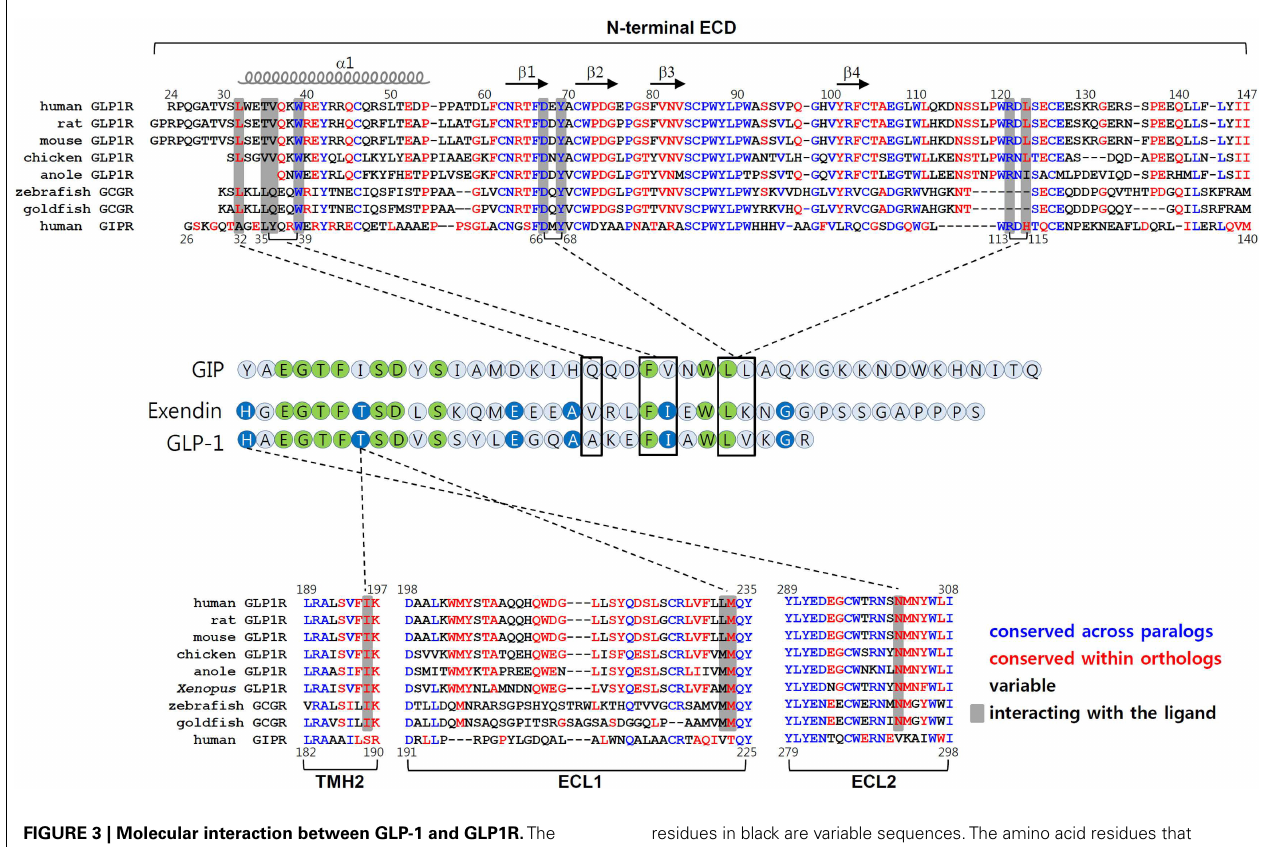
FIGURE 3 | Molecular interaction between GLP-1 and GLP1R. The amino acid sequences of the N-terminal ECD,TMH2, ECL1, and ECL2 of vertebrate GLP1Rs, fish GCGRs (which are known to bind GLP-1), and human GIPR are shown in top and bottom panels.The residues in blue are conserved between GLP1Rs and GIPR. Residues shown in red are conserved sequences within the orthologous receptor of vertebrates.The